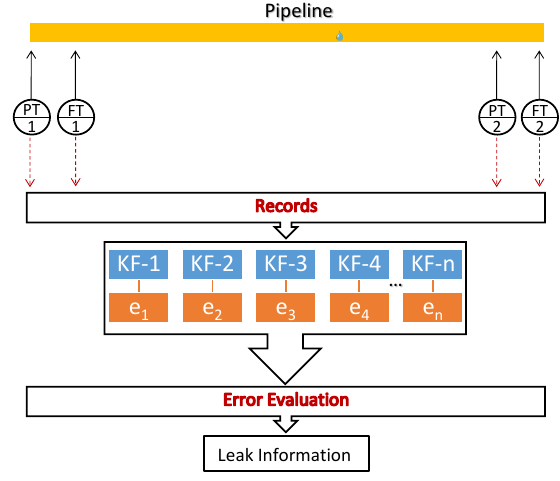
Figure 5. Architecture of the approaches based on a bank of Kalman